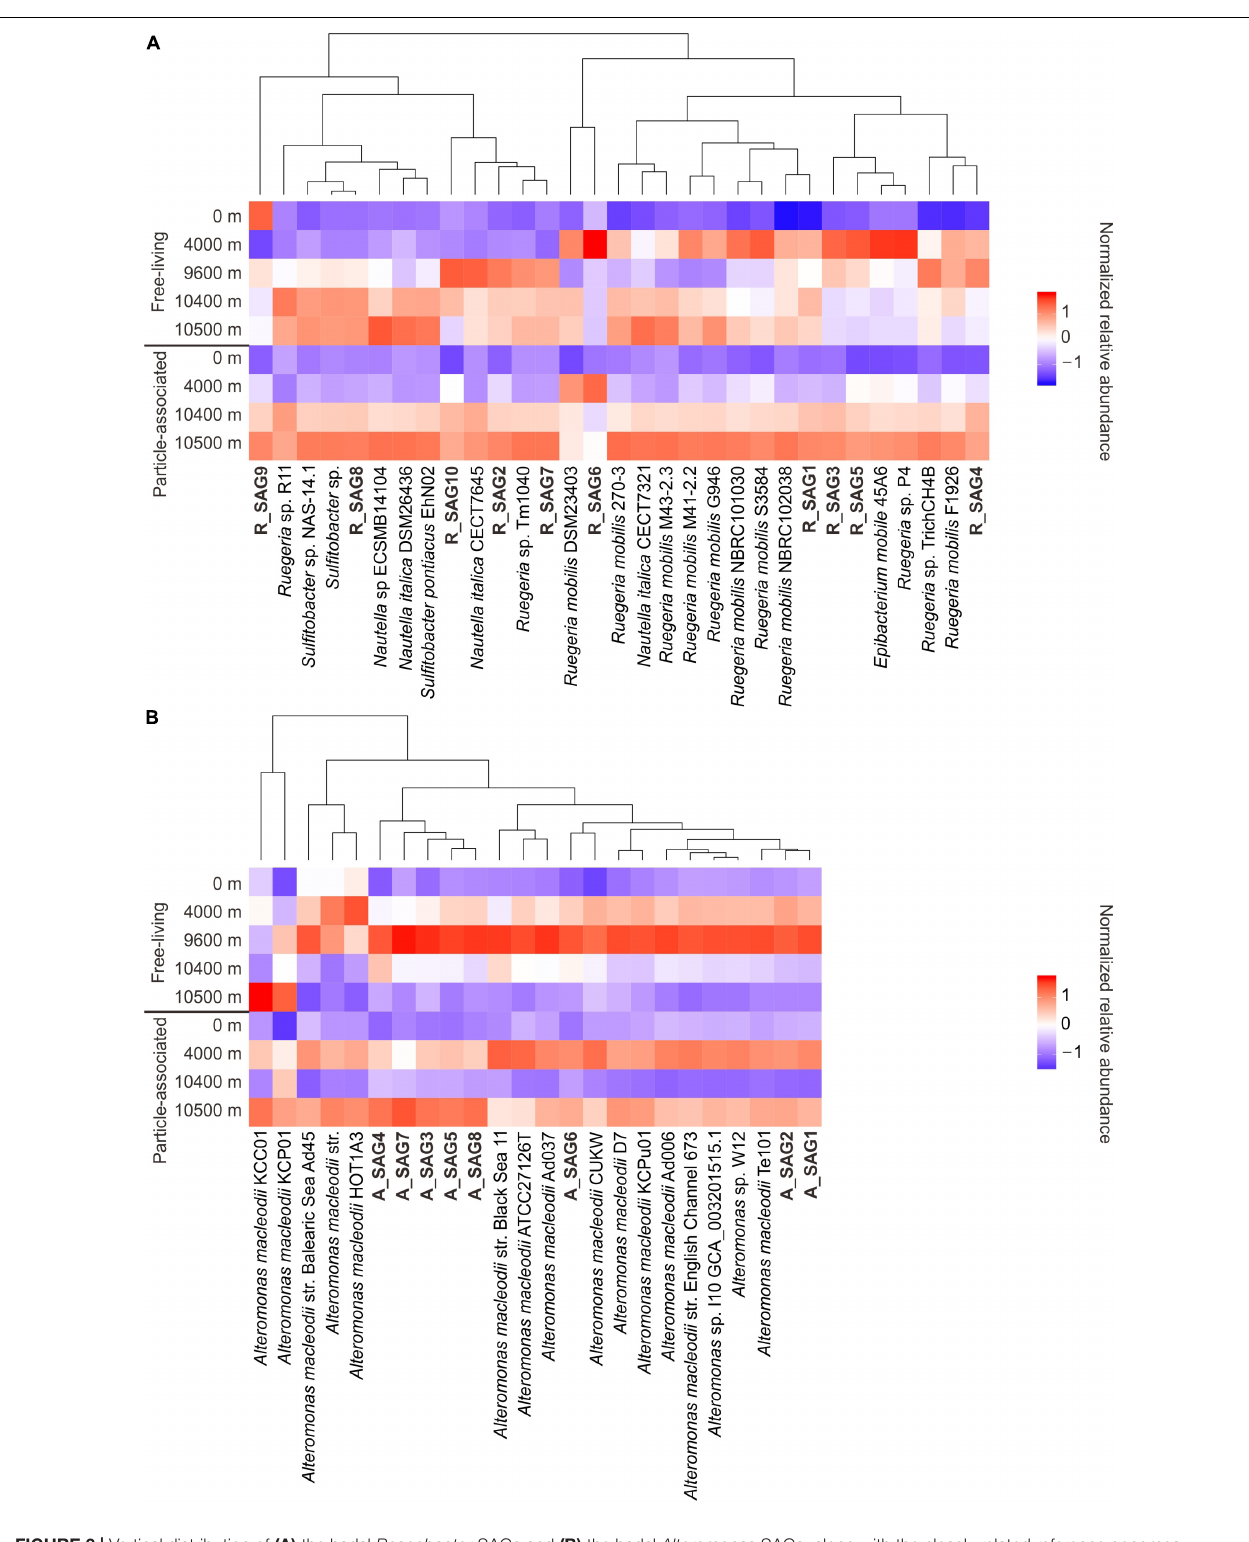
Frontiers in Microbiology |